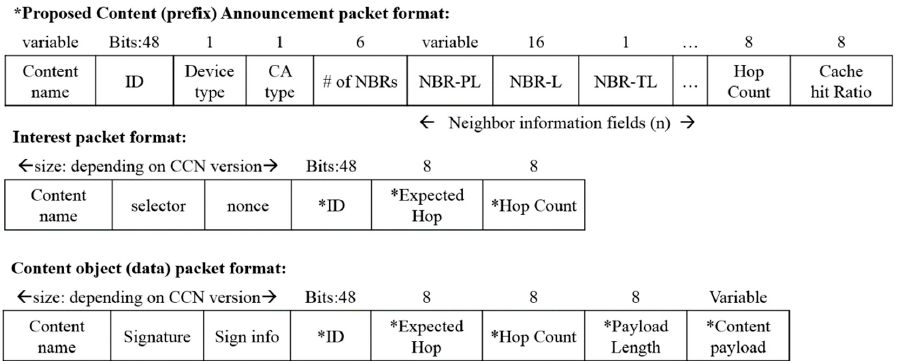
Figure 4. Frame format of the TOP-CCN, *: extended or new elements of the TOP-CCN compared to pure CCN [2].